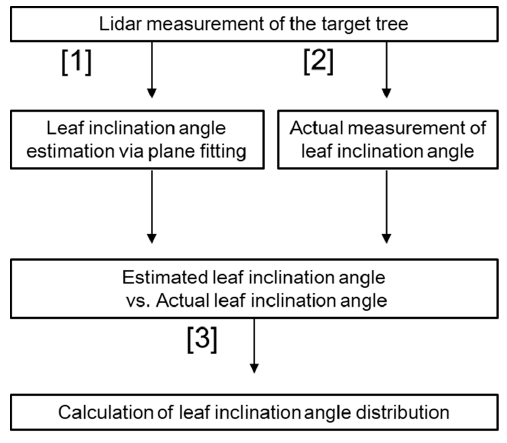
Figure 2. Flow chart of the experiment.